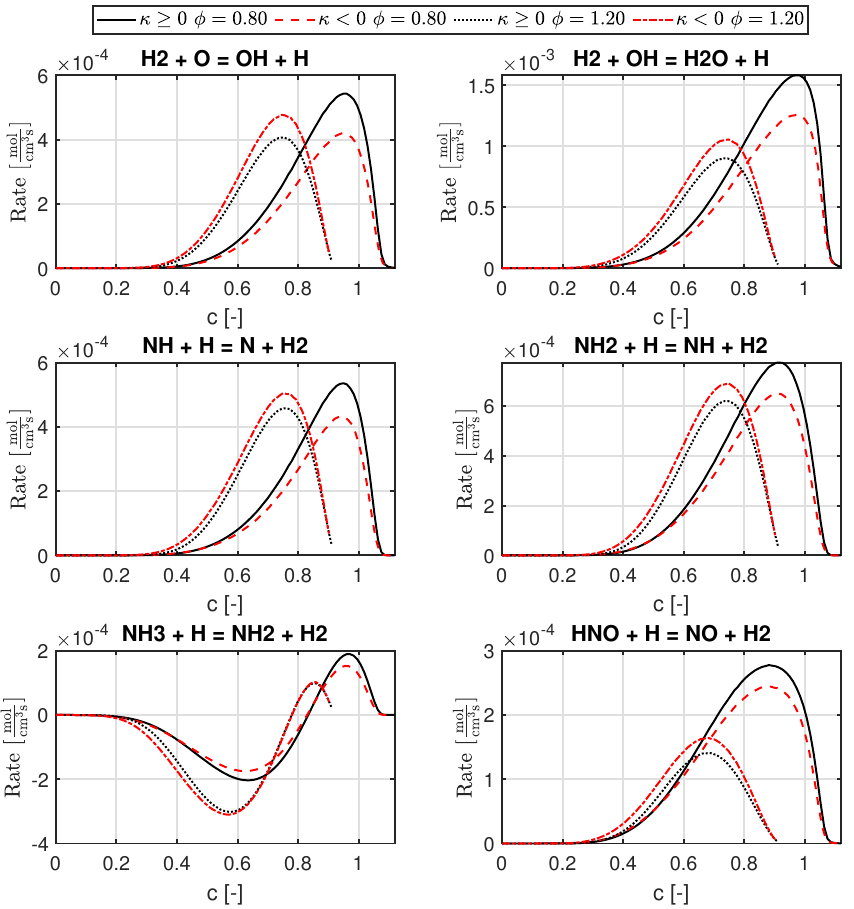
Figure 6. Reaction rates of reactions involving H 2 doubly conditioned on curvature and progress variables for 75% ammonia